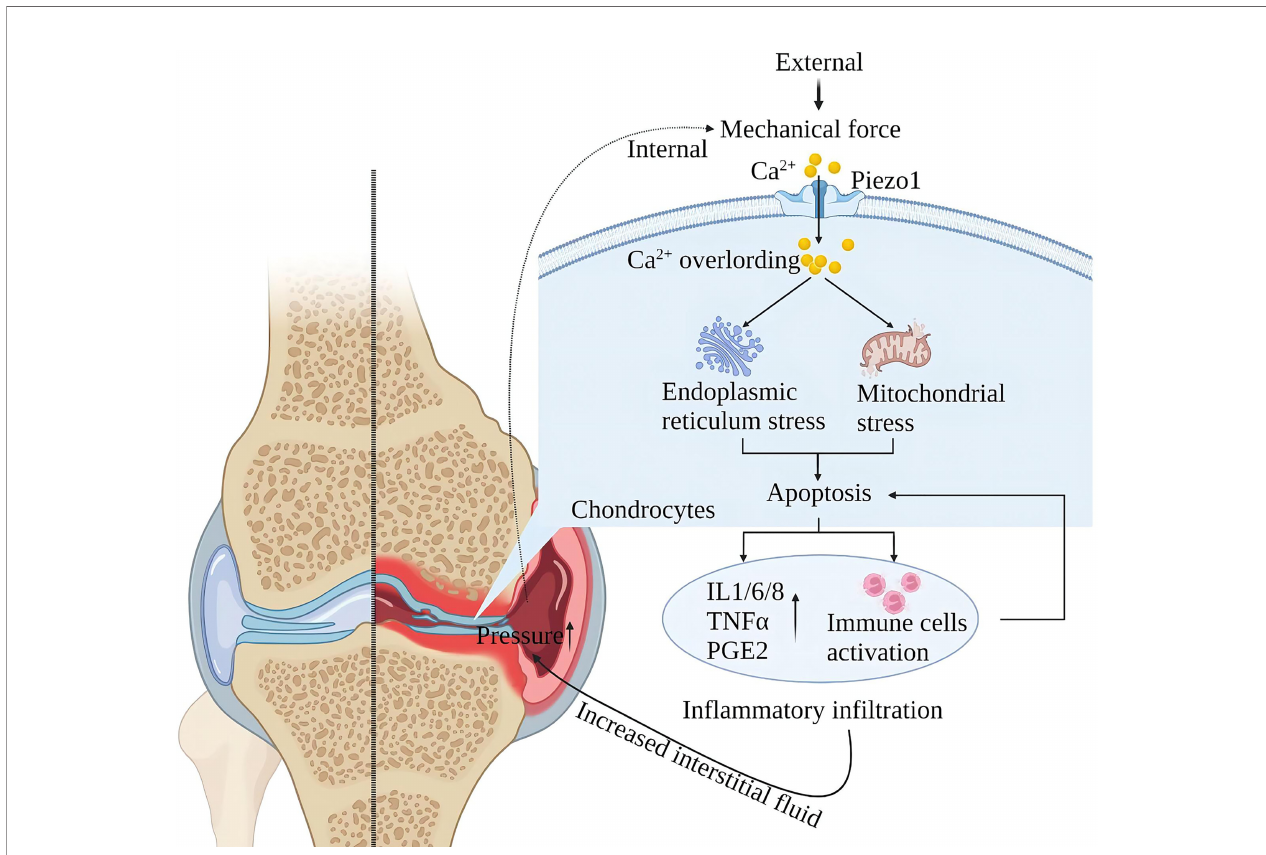
FIGURE 8 | Schematic diagram of the role of Piezo1 in OA. Mechanical force activates Piezo1 on articular cartilage cells, induces Ca 2+ overload, endoplasmic reticulum, and mitochondrial stress, leading to in fl ammation and apoptosis of chondrocytes. Cartilage cell damage leads to exudation of interstitial fl uid and in fl ammatory in fi ltration. In fl ammatory in fi ltration damages the nascent cartilage tissue, and exudation leads to increased intra-articular pressure, further activating Piezo1, creating a vicious injury